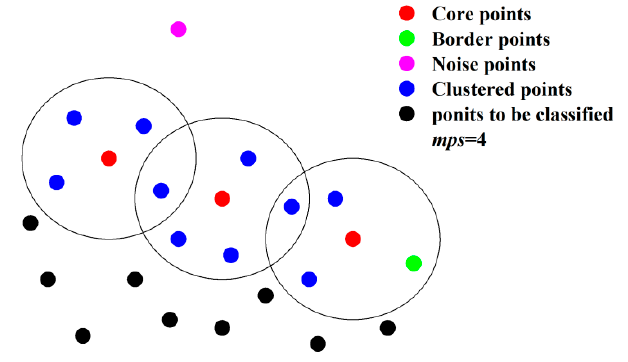
Figure 1. Clustering principle of the DBSCAN algorithm.